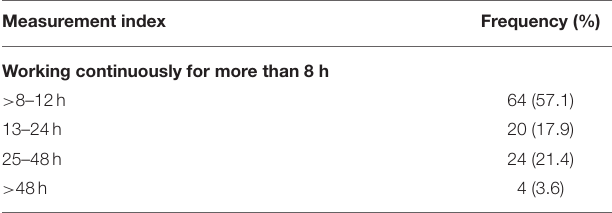
TABLE 3 | Last work status of overwork death victims before